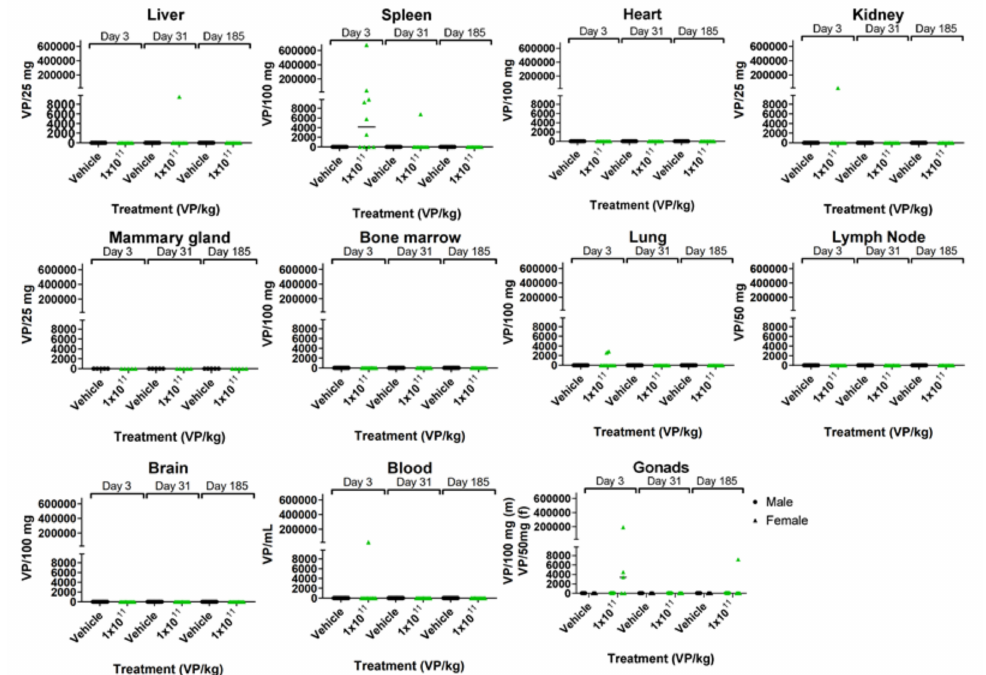
Figure 5. TILT-123 biodistribution in hamsters: the hamsters received six TILT-123 injections i.p. at the dose of 1 × 10 11 VP/kg. The presence of TILT-123 in hamster tissues was studied with qPCR at three time points (3, 31, and 185 days after the first treatment). Only values above the limit of quantification are